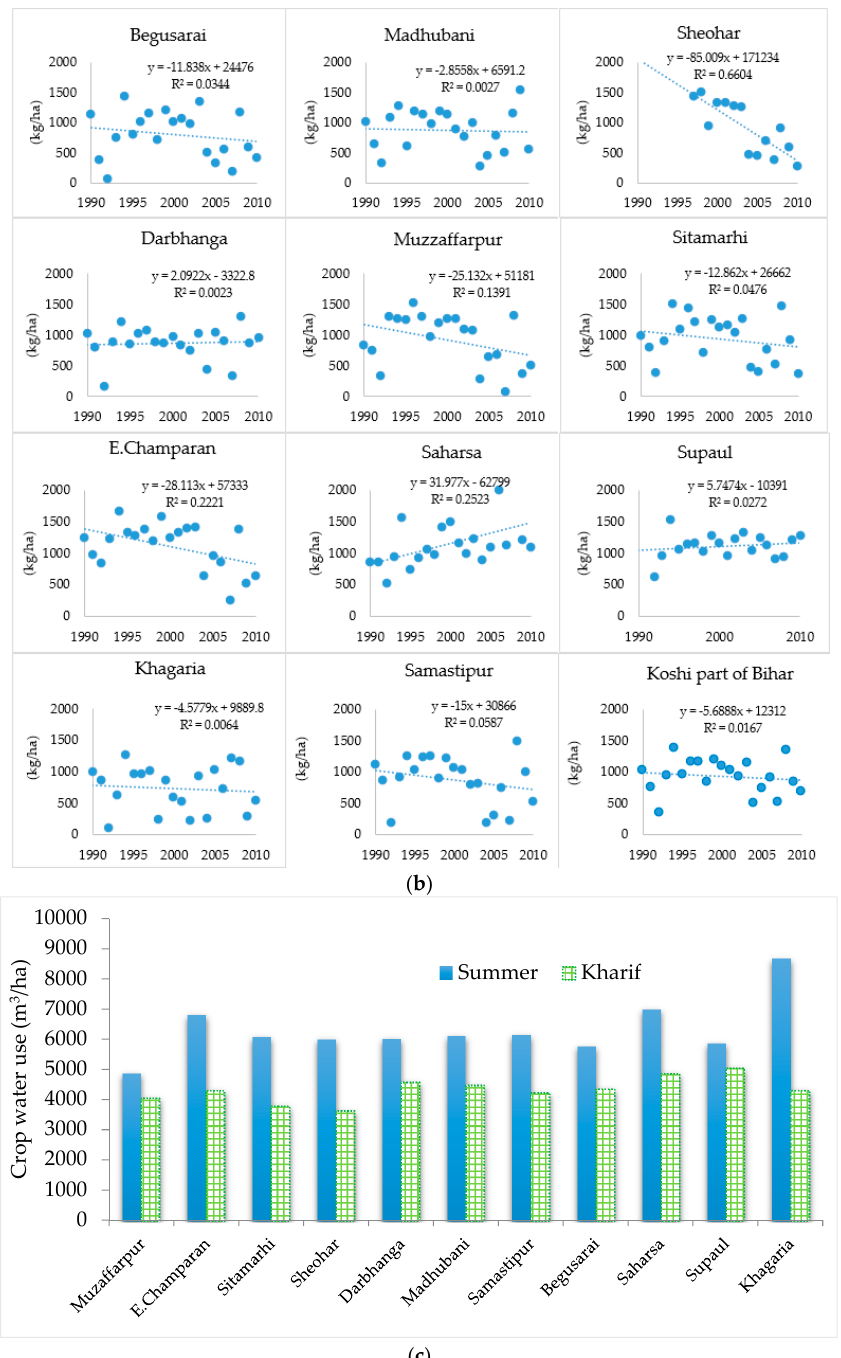
Figure 3. ( a ) Rice WP (kg/m 3 ) over time (shown in linear trend lines) in the Koshi districts of Bihar, individually and overall (1991–2010); ( b ) Rice yield (kg/ha) over time (shown in linear trend lines) in the Koshi districts of Bihar, individually and overall (1991–2010); ( c ) Consumptive water use in the Koshi districts of Bihar (1991–2010).